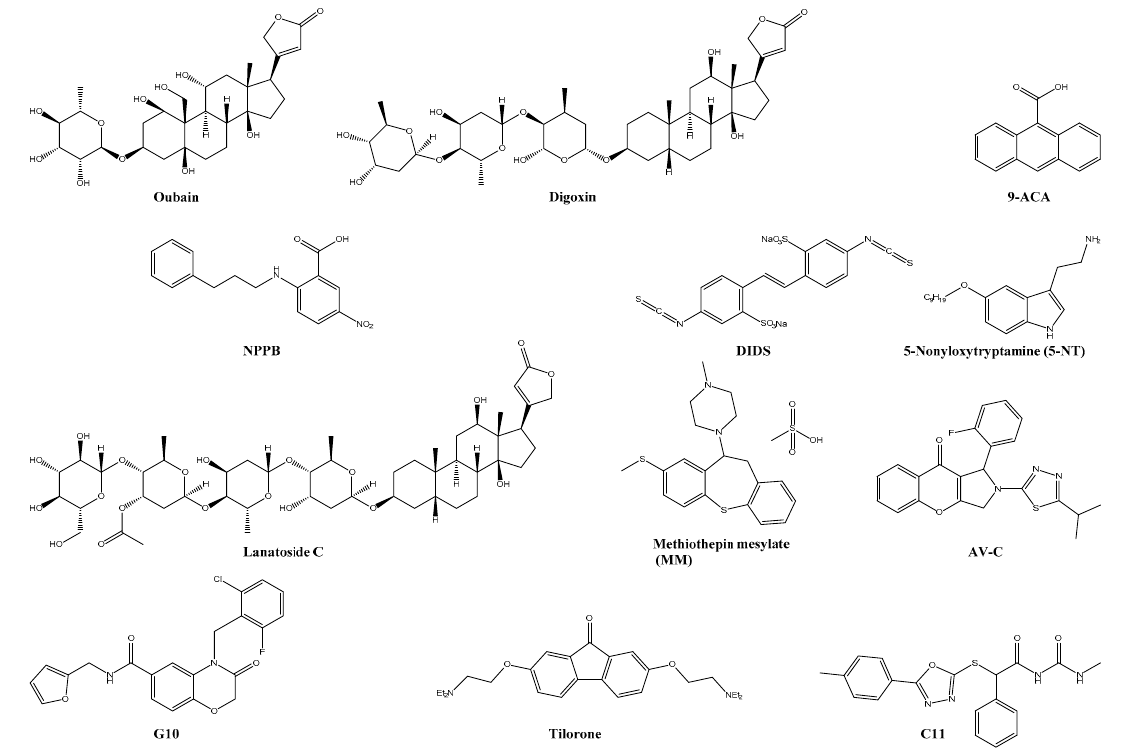
Figure 5. Chemical structure of selected host-targeting compounds. Inhibitors of cellular receptors: oubain, digoxin, lanatoside C, DIDS, 9-ACA, NPPB, 5-nonyloxytryptamine, and methiothepin mesylate. Immunomodulatory agents: tilorone, C11, G10, and AV-C.